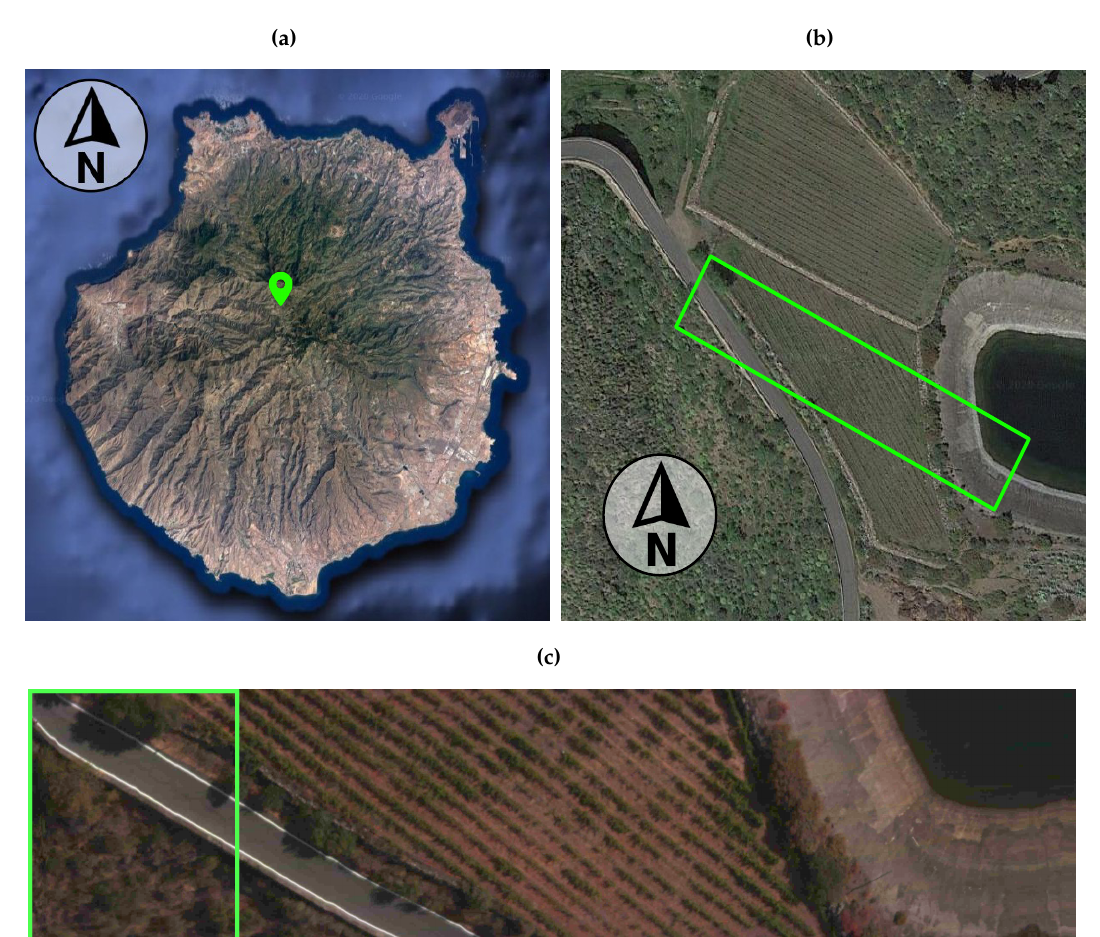
Figure 7. Graphical description of the appearance and location of the terrain corresponding to the image used in this work for the experiments. ( a ) Google Maps pictures indicating the terrain location on the island of Gran Canaria. ( b ) Google Maps pictures indicating the area covered during the selected swath of the flight campaign over the vineyard. ( c ) RGB respresentation of the real hyperspectral data, highlighting the portion of it that was used for the